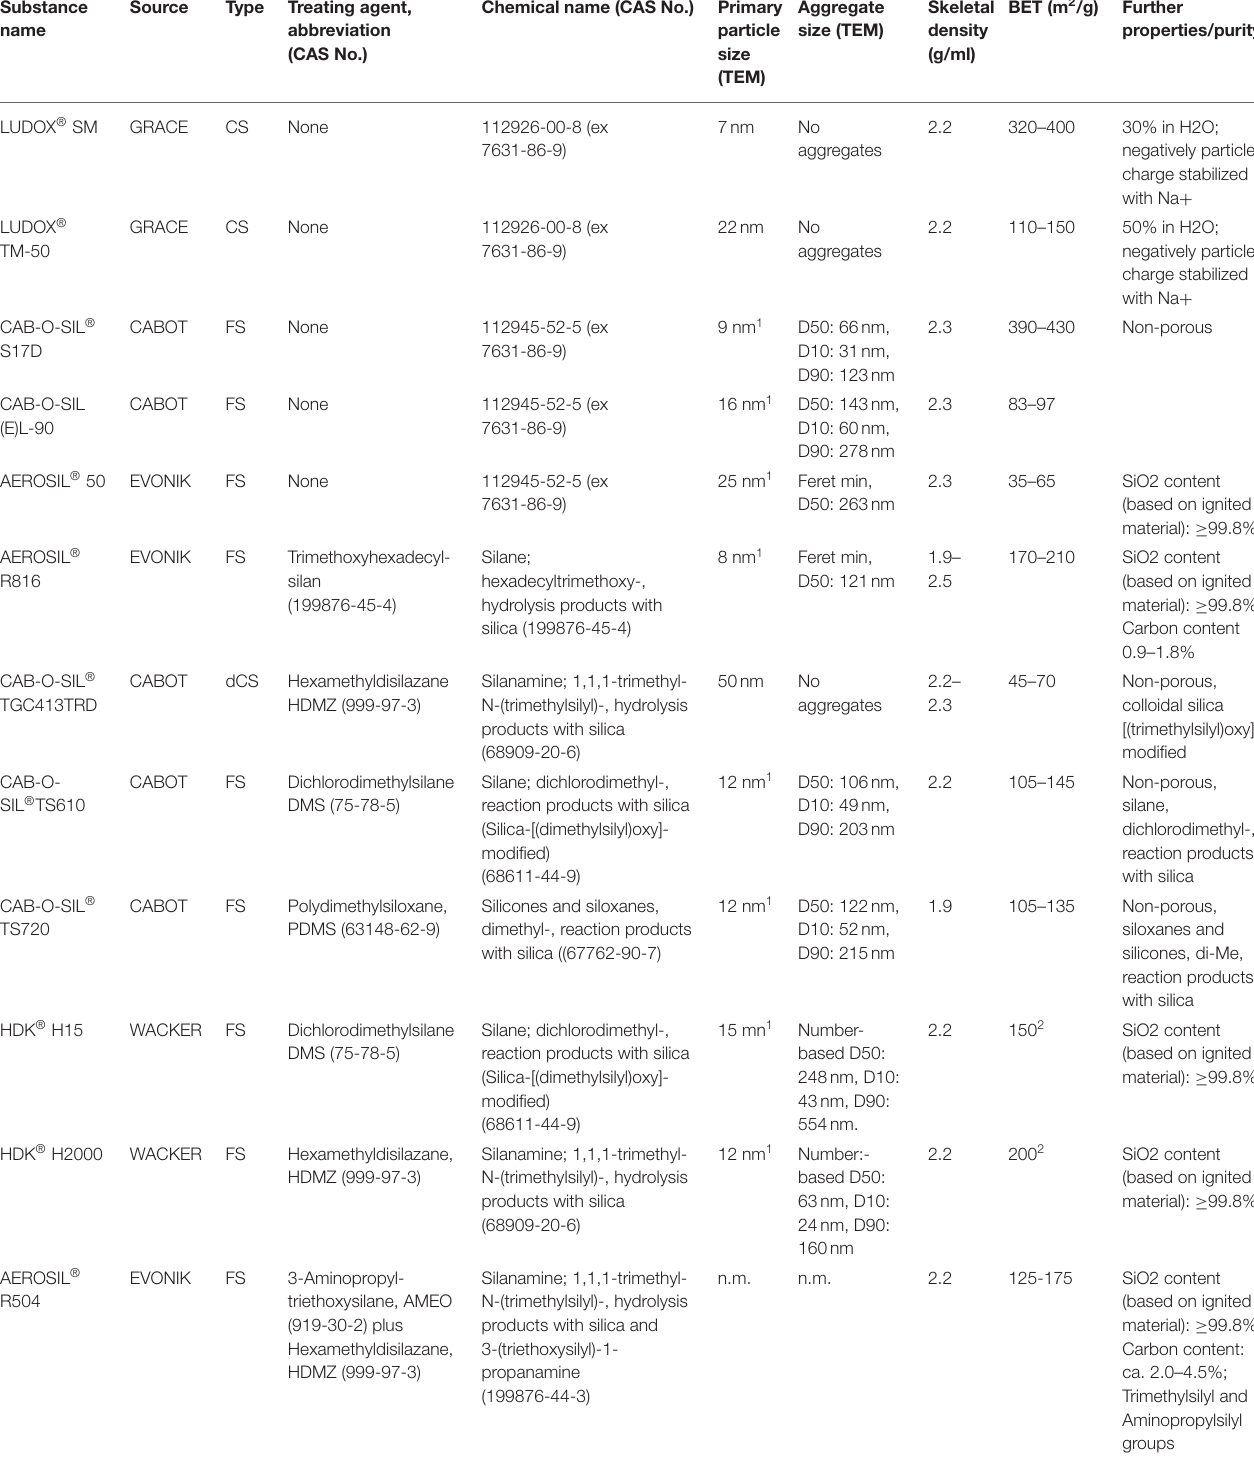
TABLE 1 | List of materials, coating agents, surface modifications, and properties of